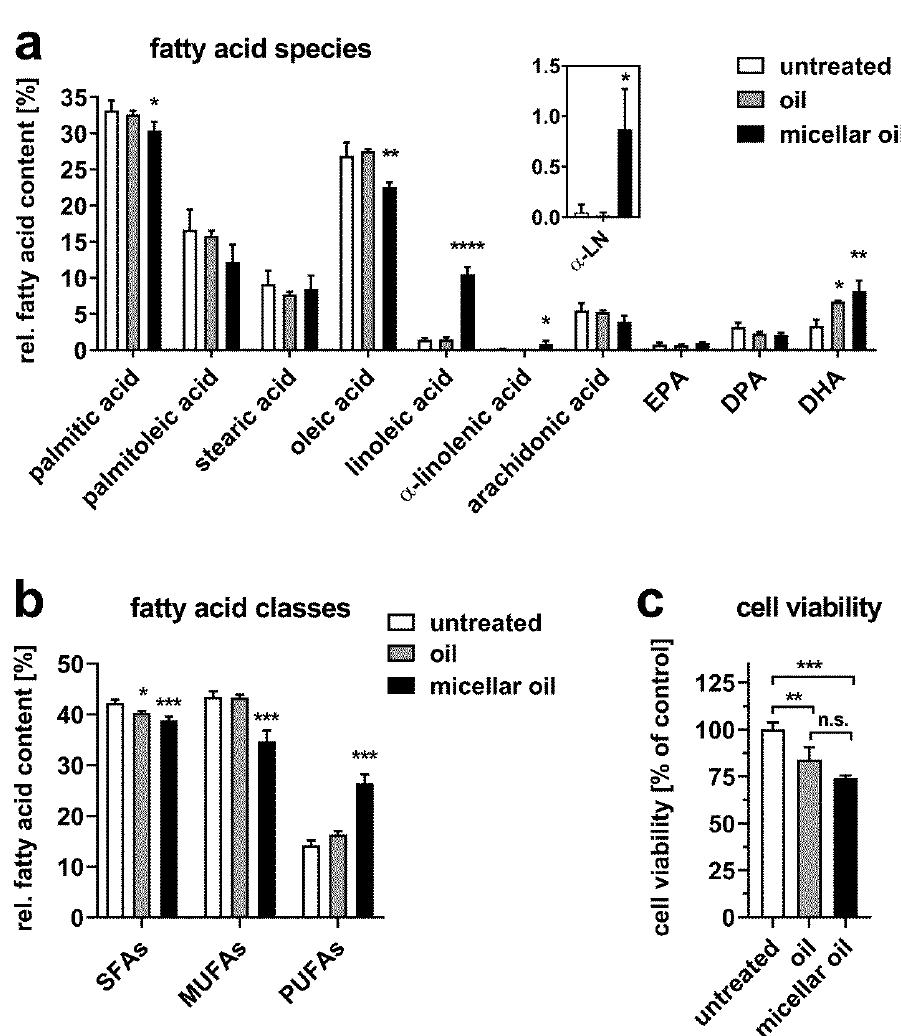
Figure 2. Uptake of fatty acids from algae oil into nondi ff erentiated Caco-2 cells. Cells incubated with native or micellar oils at a final concentration of 1% for 6 h. The total fatty acid content was measured by GC-MS. The relative fatty acid composition ( a ) and distribution of fatty acid classes ( b ) are shown. The inset indicates an enlarged view on α -linolenic acid ( α -LN) levels. Cell viability was assessed after incubation with 1% oil or micellar oil for 24 h ( c ). Data are derived from three independent experiments. Bars represent mean ± SD. Asterisks indicate statistically significant di ff erences from untreated controls. **** p < 0.0001, *** p < 0.001, ** p < 0.01 and * p <